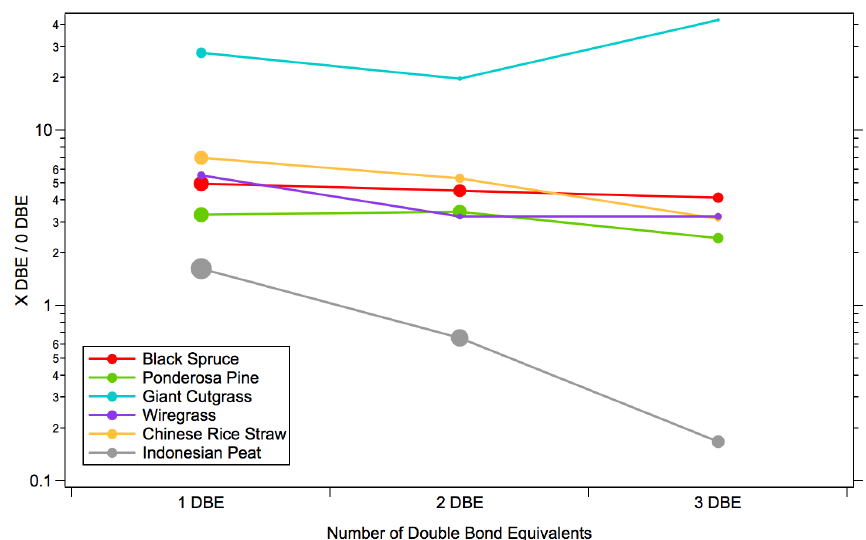
Figure 9. Ratio of the EFs for unsaturated aliphatic hydrocarbons (separated by double bond equivalents, DBE) vs. alkanes. The marker sizes are proportional to the average carbon number (from 5 to 8) at each